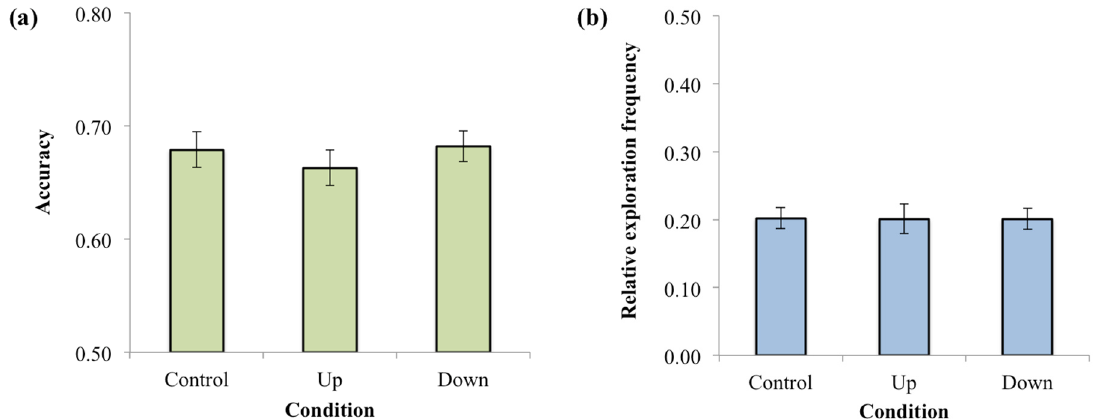
Figure 4. Group means of performance and behavior with 95% confidence interval for each value. ( a ) Accuracy of choosing the button with the highest value across conditions; ( b ) Relative exploration frequency in three experimental